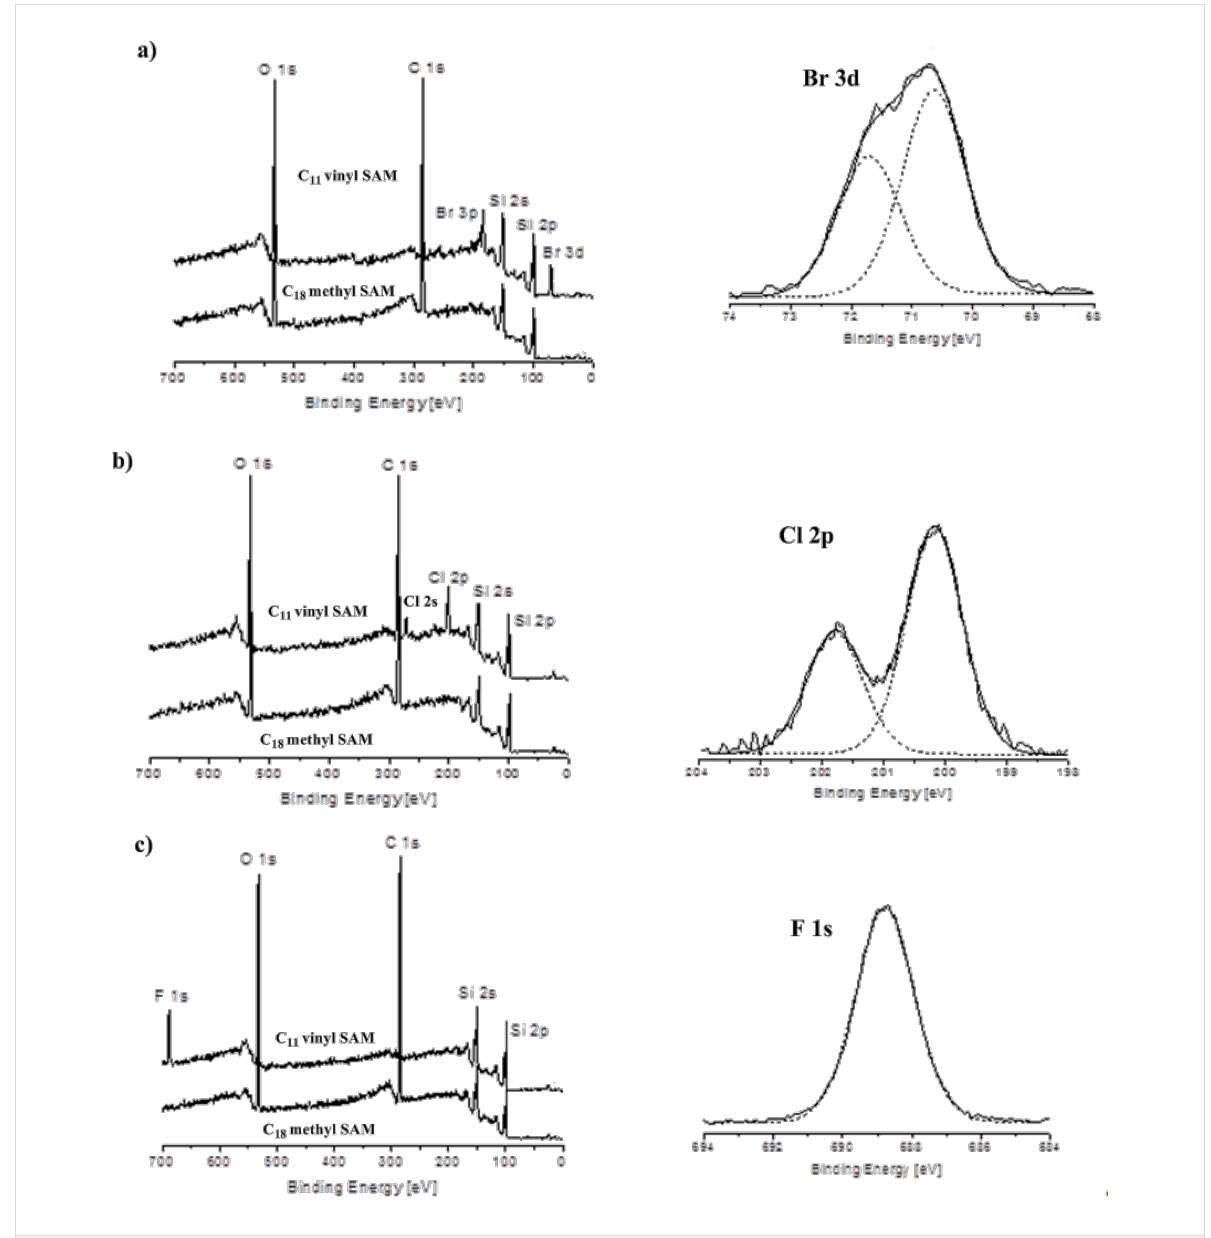
Figure 2: XPS scans after reactions with a) :CBr 2 ; b) :CCl 2 and c) :CF 2 . In each case the upper traces are scans of C 11 -vinyl SAMs, and the lower traces are C 18 -Me-terminated SAMs each treated with the relevant carbene reaction solution. The expanded regions on the right hand side, asso- ciated with each C 11 -vinyl SAM spectrum, show the key halide specific XPS signals.